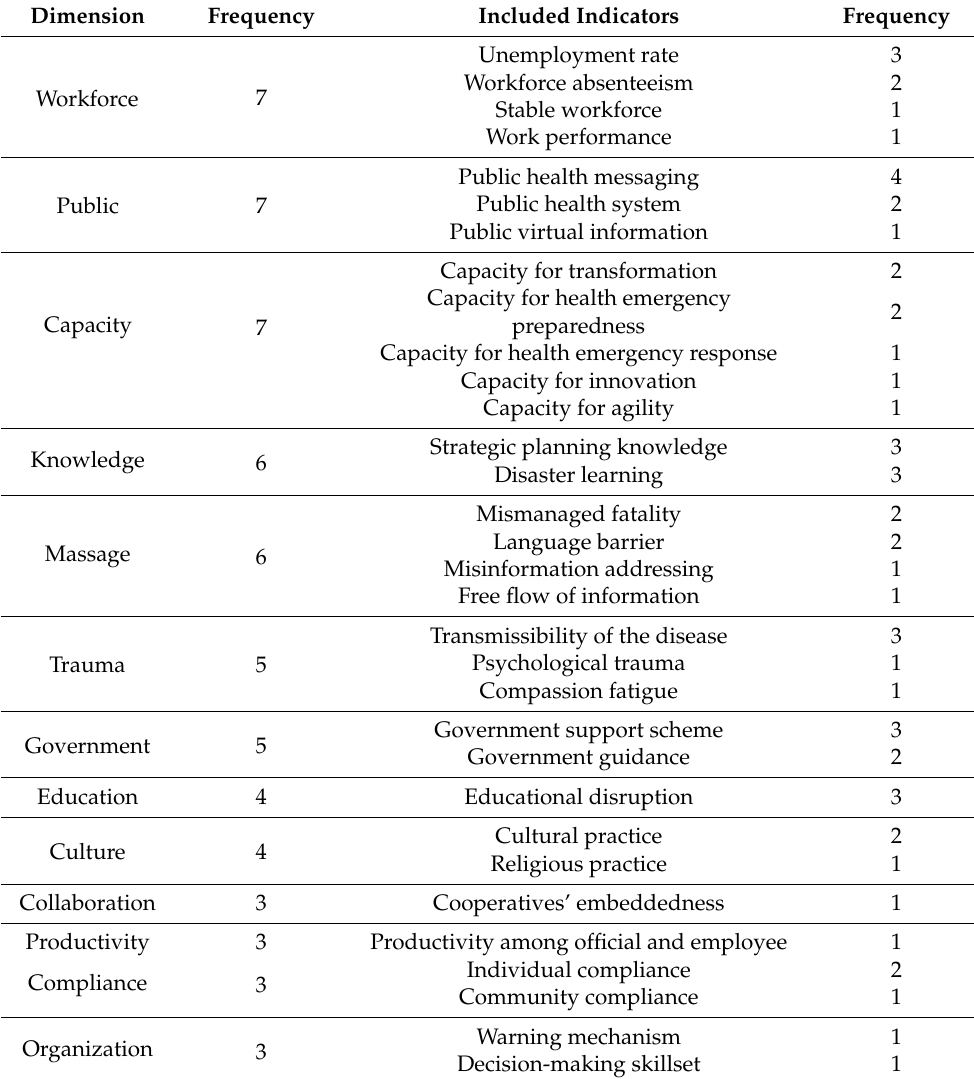
Table A1. Cont. Dimension Frequency Included Indicators